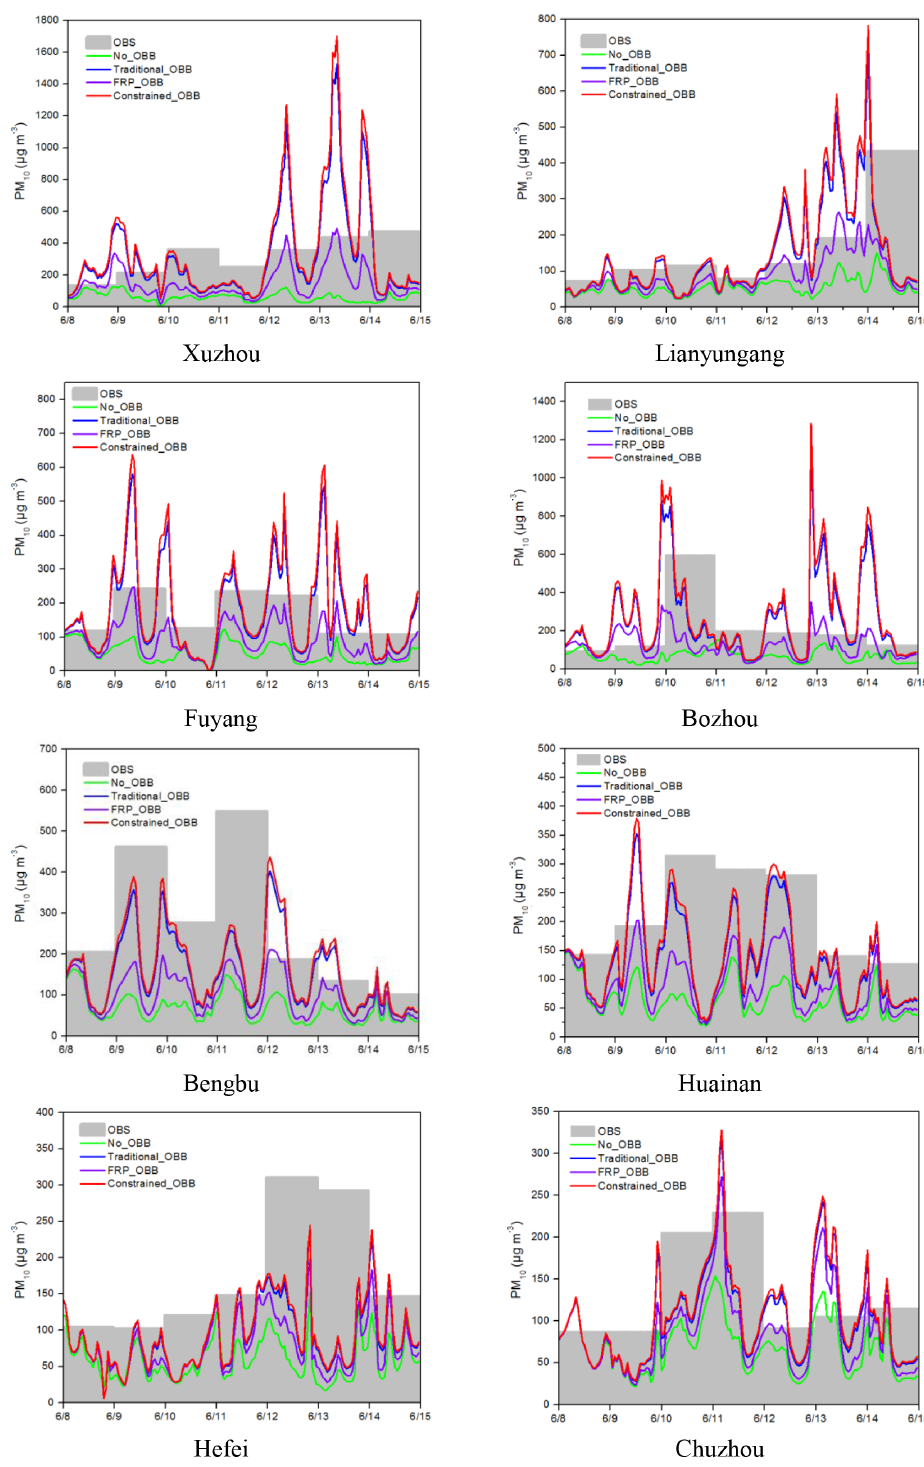
Figure 5. Observed 24h averaged PM 10 concentrations and simulated hourly PM 10 concentrations without OBB emissions (No_OBB) and with OBB emissions based on traditional bottom-up (Traditional_OBB), FRP-based (FRP_OBB) and constraining